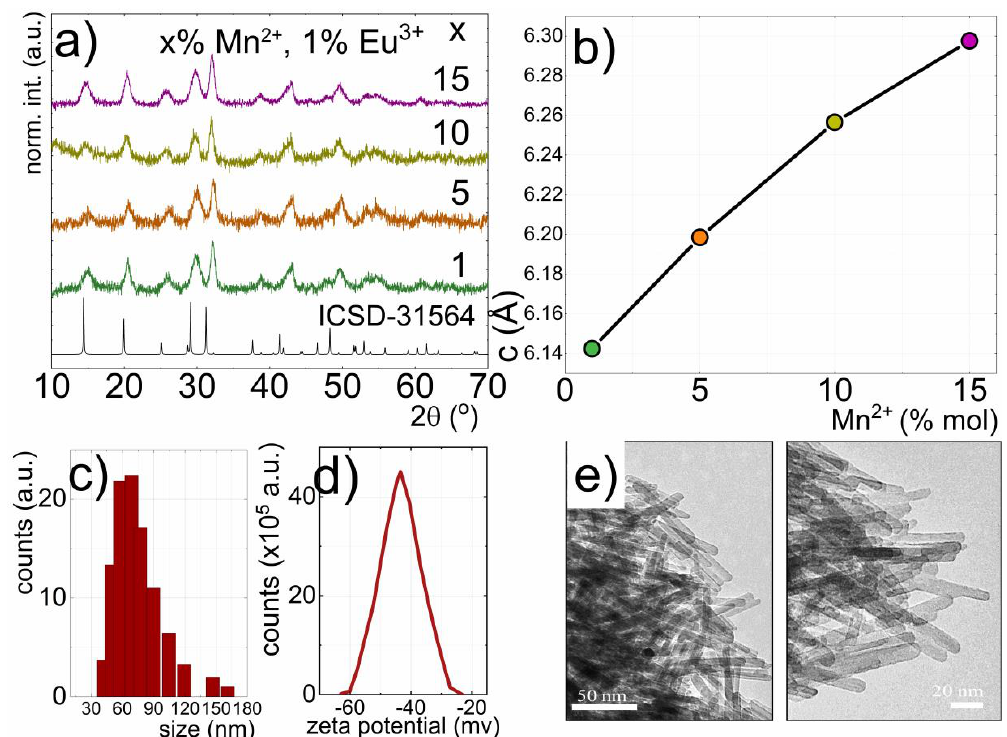
Figure 1. XRD patterns for GdPO 4 doped with 1, 5, 10, and 15% Mn 2+ ; 1% Eu 3+ ( a ); influence of the Mn 2+ concentration on the c cell parameter ( b ); the GdPO 4 : 10% Mn 2+ , 1% Eu 3+ nanoparticle size distribution determined from DLS measurement ( c ); zeta potential of their colloidal solution in water ( d ); the representative TEM images of GdPO 4 : 10% Mn 2+ , 1% Eu 3+ nanoparticles ( e ).